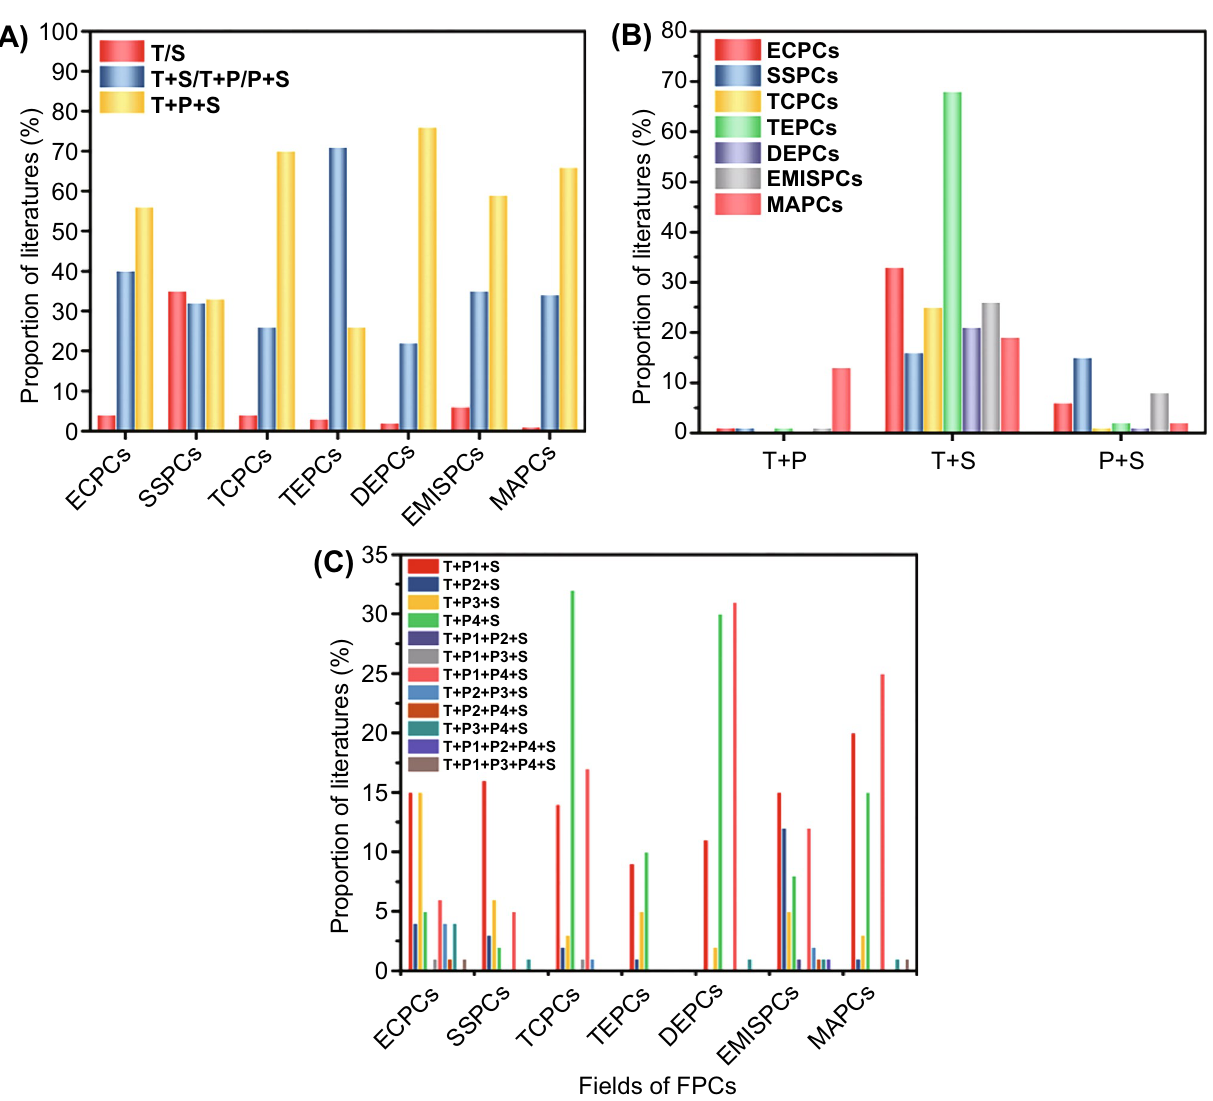
Fig. 9 Proportion of literature for A single-type of tools, dual-type of tools, and ternary-type of tools in 100 literature of each field of FPCs, B different dual type of tools in 100 literature of each field of FPCs, C different ternary type of tools in 100 literature of each field of FPCs. Abbre- viations: ECPCs (electrically conductive polymer composites); SSPCs (strain/pressure sensing polymer composites); TCPCs (thermally conduc- tive polymer composites); TEPCs (thermoelectric polymer composites); DEPCs (dielectric polymer composites); EMISPCs (electromagnetic interference shielding polymer composites); MAPCs (microwave absorbing polymer